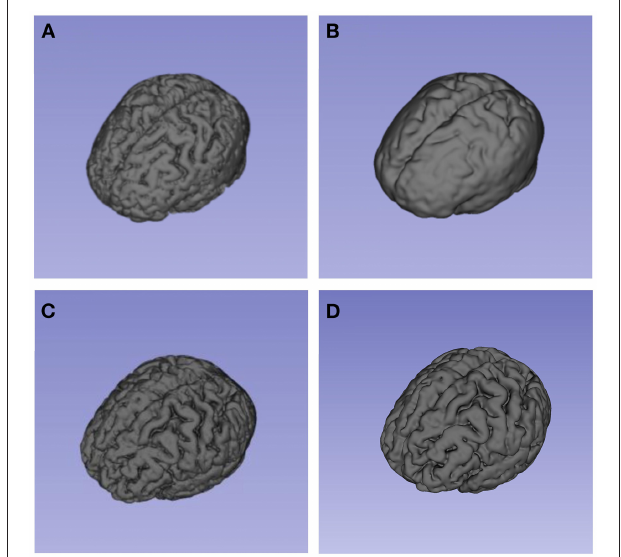
FIGURE 4 | These models present the segmentation result (brain volume) of 3D-Slicer. (A) and (B) showed the brain volume of a patient in brain swelling group at different time points. (A) showed his brain volume within 24h after bleeding. As shown in (B) , the patient developed typically brain swelling with the disease progressed. This patient’s CRBV was 11. 35%. By comparison, (C) and (D) showed the brain volume of a patient in non-brain swelling group. The patient’s CRBV was